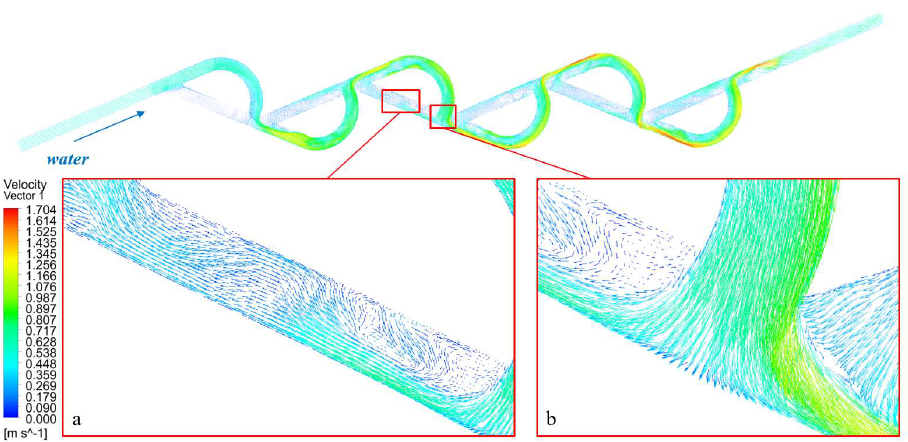
Figure 11. Velocity vector cloud distribution (( a ) main migration channel, ( b ) unit node).